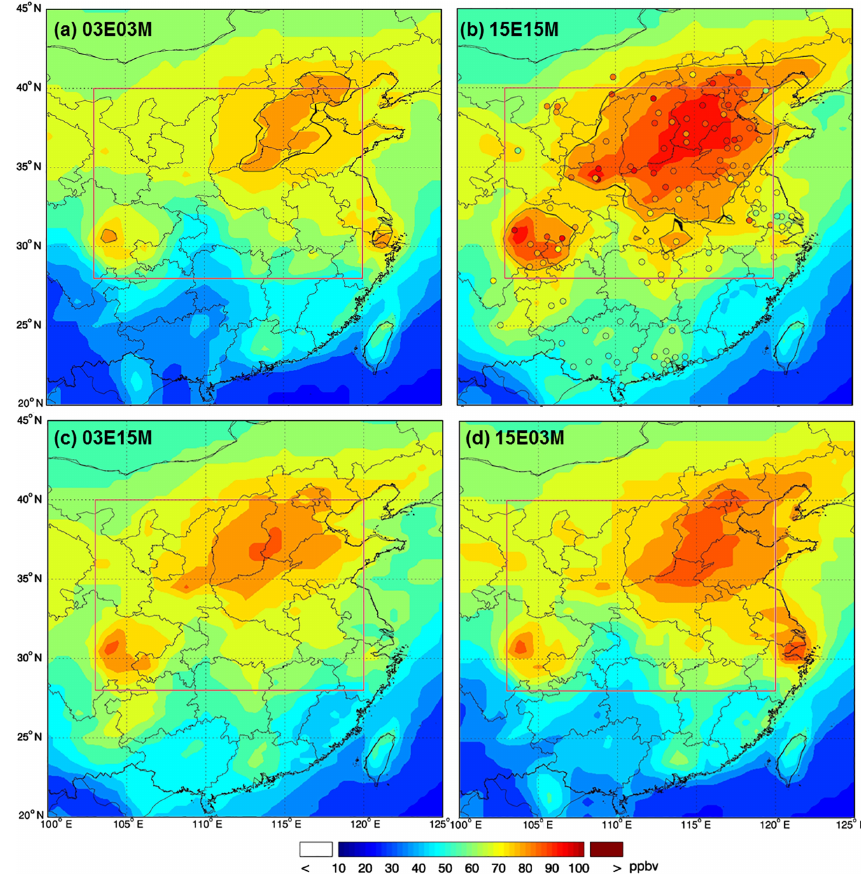
Figure 2. Monthly mean spatial distributions of surface MDA8 O 3 in July over east China. (a) 03E03M: 2003 standard simulation; (b) 15E15M: 2015 standard simulation; (c) 03E15M: 2003 emission + 2015 meteorology; (d) 15E03M: 2015 emission + 2003 meteo- rology. Black contours in (a) and (b) indicate the regions with MDA8 O 3 > 75ppbv. Filled circles in (b) show the observed MDA8 O 3 at 115 sites of the network of the Chinese National Environmental Monitoring Center. The red rectangle represents the central eastern China region (CEC: 103–120 ◦ E, 28–40 ◦